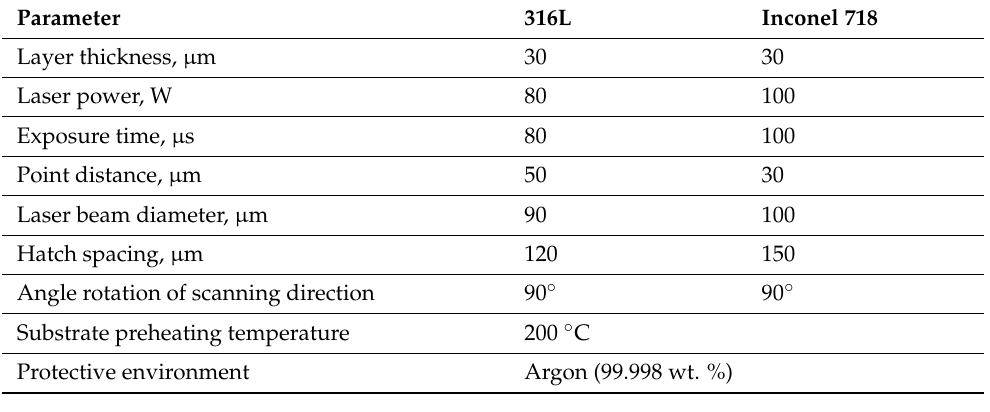
Table 2. Basic parameters of selective laser melting.